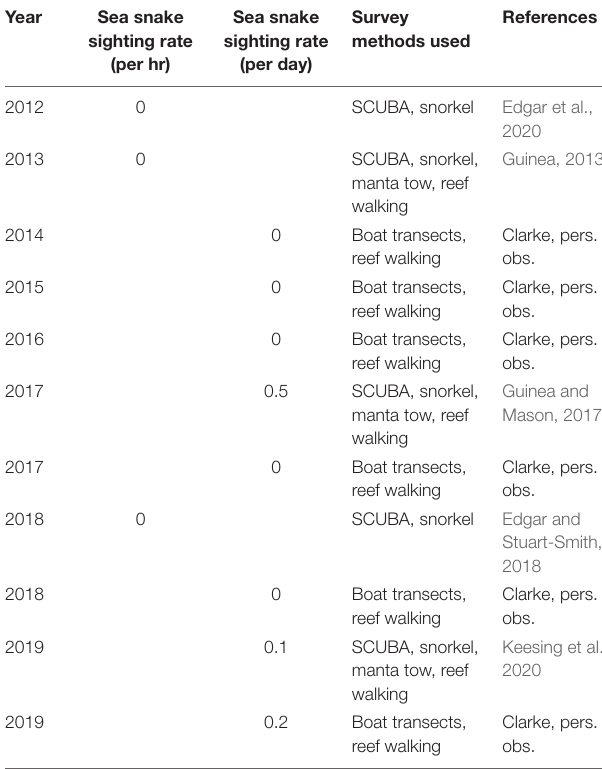
TABLE 1 | Scientific survey history and sea snake abundance at the inner reef at Ashmore Reef Marine